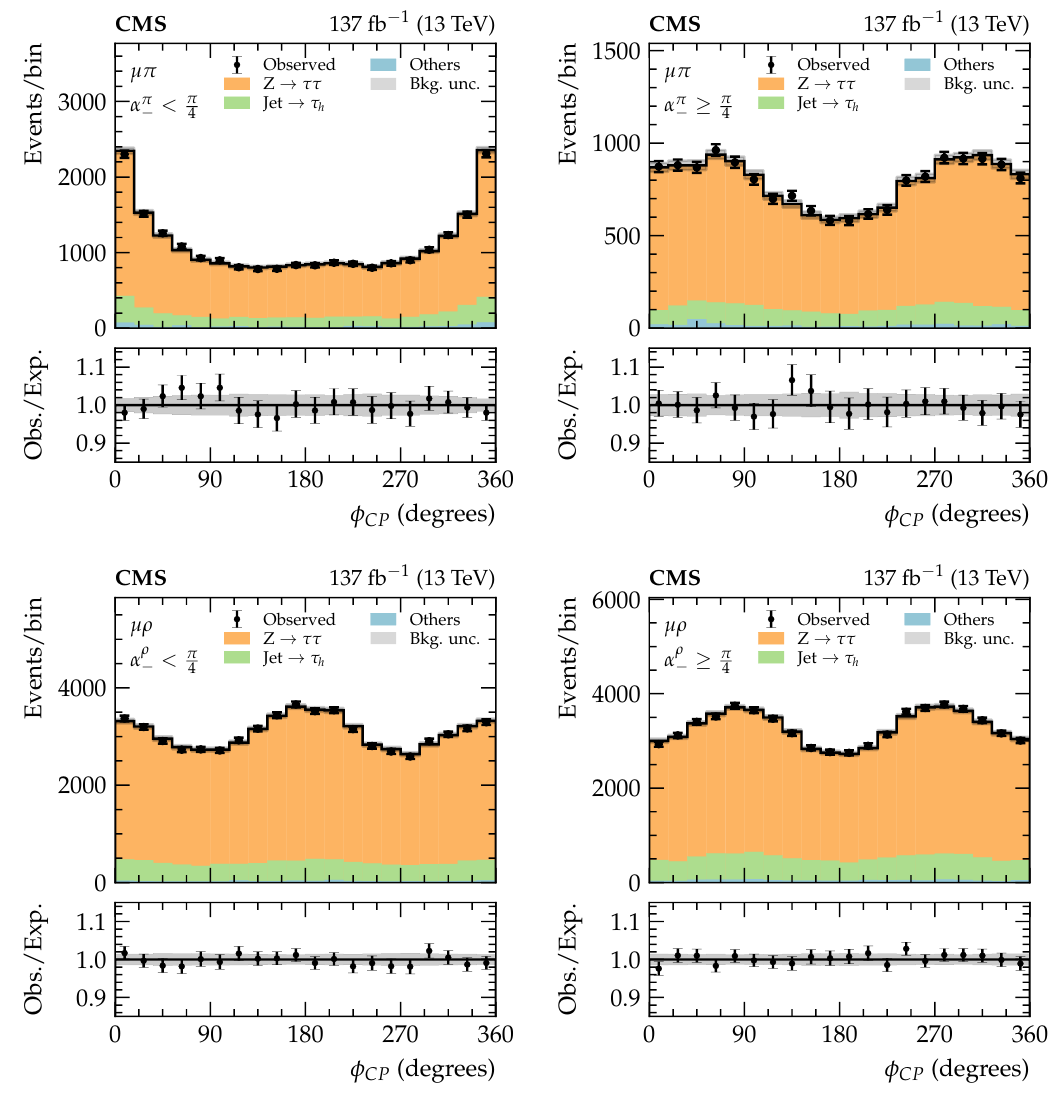
for t Figure 5 . The angle φ t h events in which the t h decays to a charged p (upper) or a charged CP m r meson (lower). The distributions are decomposed in a subset in which the charged p is “nearly coplanar” (left) or “nearly perpendicular” (right) to the production